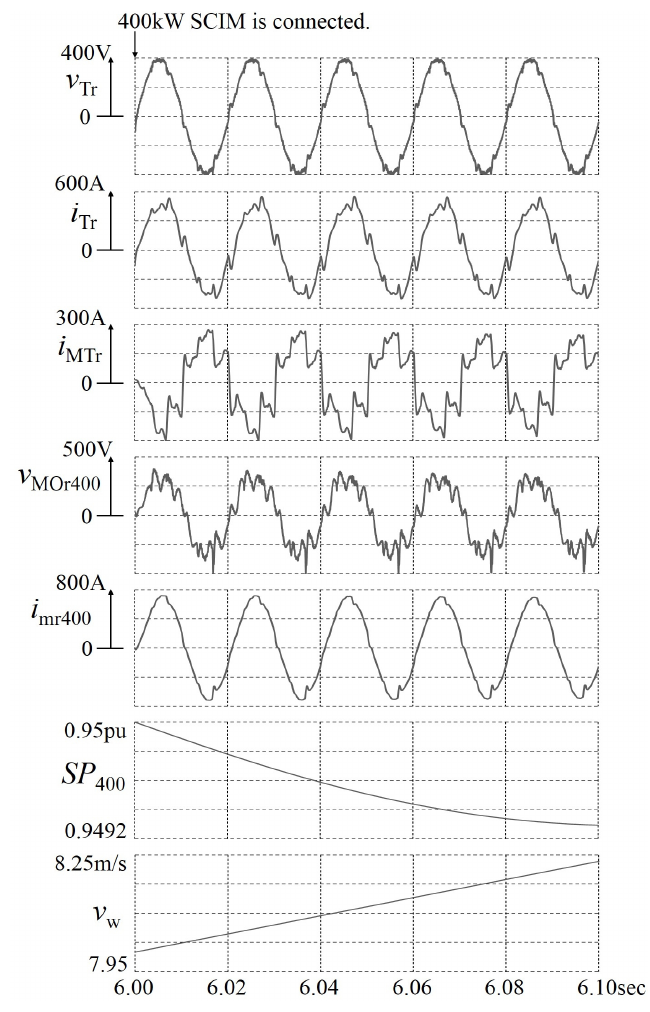
Figure 15. Simulation waveforms with the proposed inrush current suppressor for the 400-kW